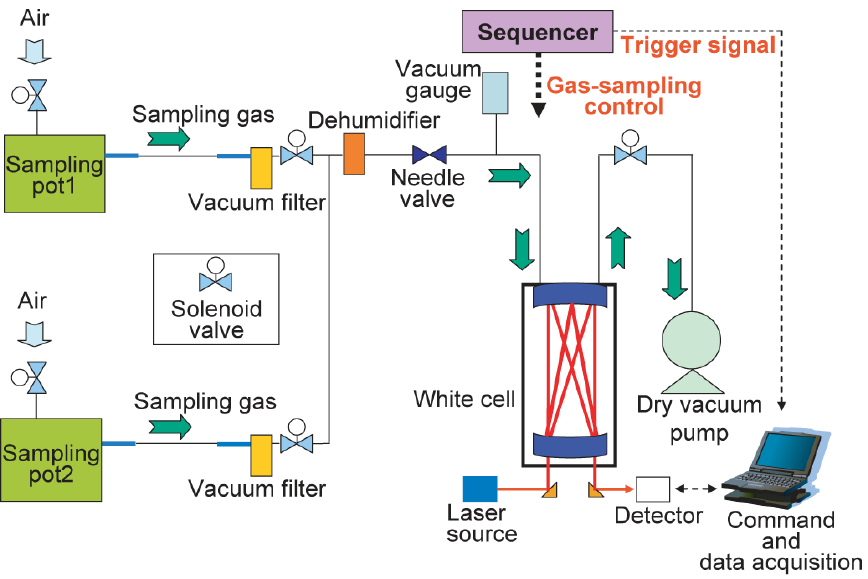
Figure 7. Schematic diagram of proposed monitoring system.